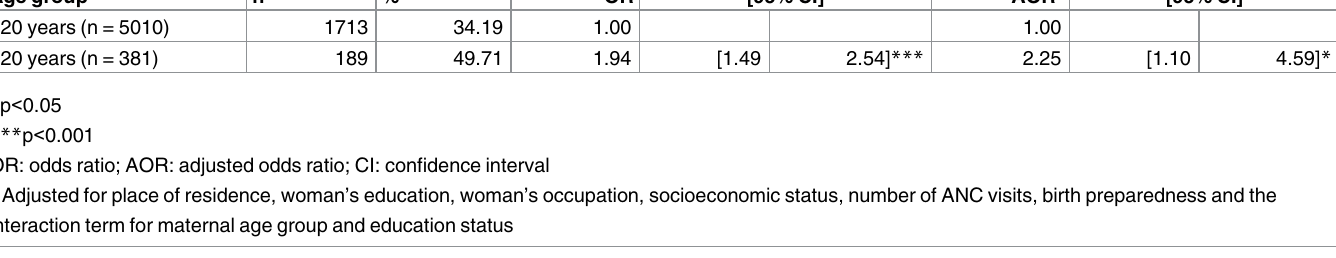
Table 2. Association between age groups and institutional delivery-NDHS 2011 (N = 5391). Age group n